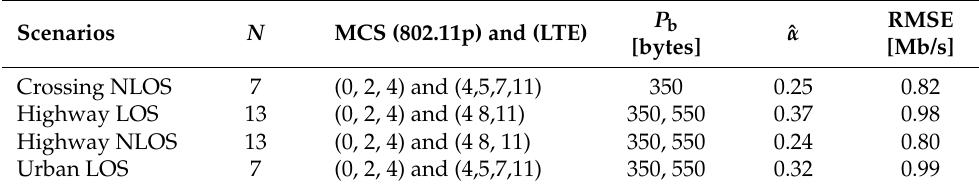
Figure 5. Impact of the implementation loss. The colored symbols show the effective throughput Ψ e ( θ ) vs. SINR threshold γ th ( θ ) for the system settings for which the PER vs. SINR curve is available, with the numbers next to them representing the MCS indexes. The solid curve is the Shannon bound corresponding to the SINR value. The dashed line is the best fit curve with the implementation loss ˆ α . Table 3. Implementation loss ˆ α in different scenarios, considering different configurations { θ | i = 1,2, . . . , N } , varying the MCS index and packet size. The RMSE of the effective throughput i with respect to the approximation is